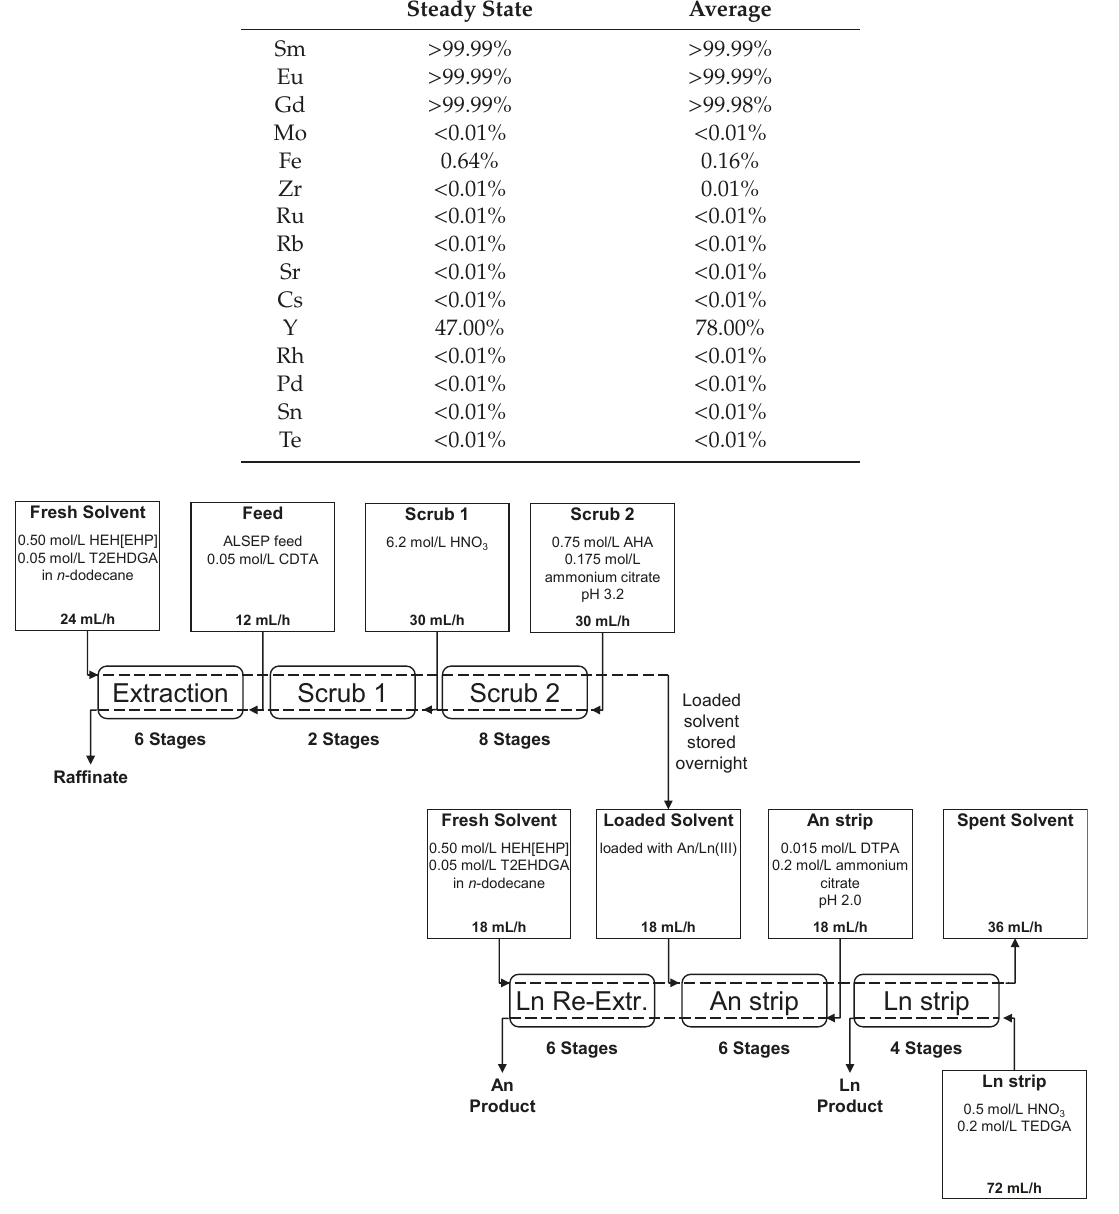
Figure 7. Flowsheet of the Actinide Lanthanide Separation Process (ALSEP) process